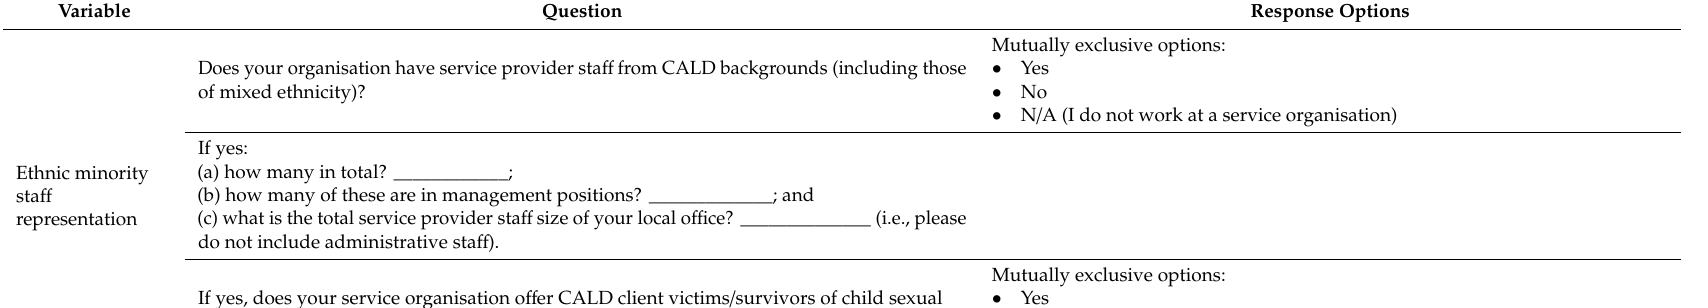
Table 3. Relevant variables assessing organisational cultural competency, question wording, and response options from the full program evaluation instrument.